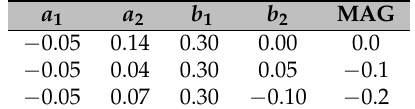
Table 3. Parameter values for simulation of the trend in Equation (8) to compare JUST with BFAST.